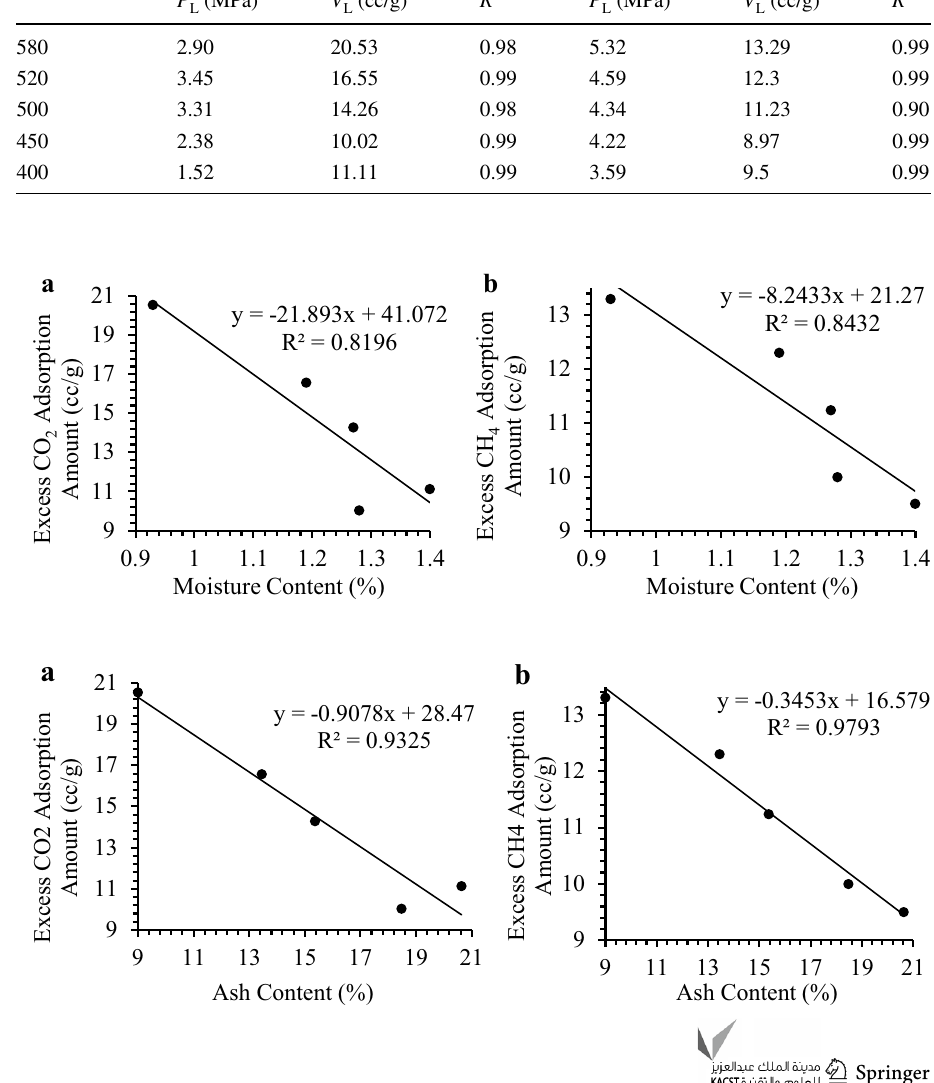
pressure of coal samples at 27 °C